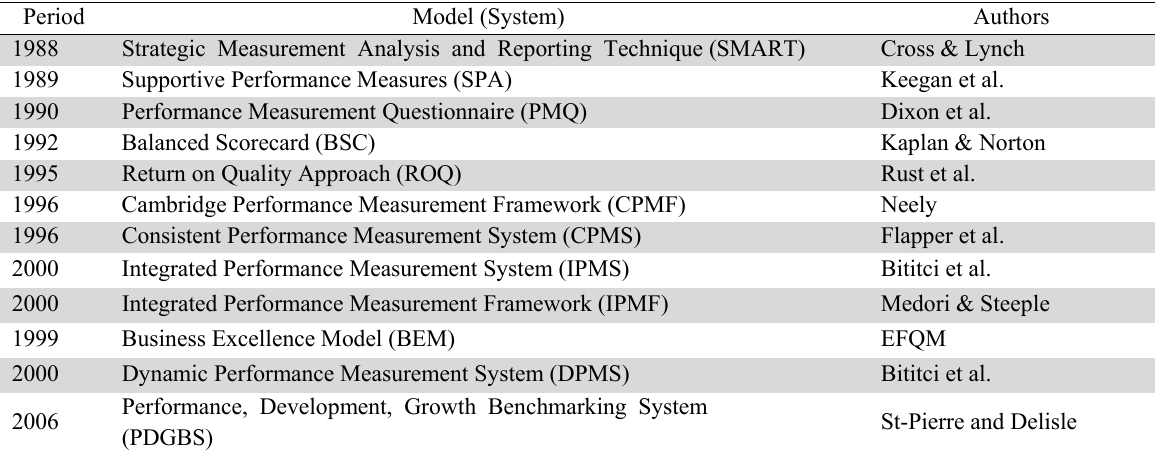
Types of evaluation models and their publication year